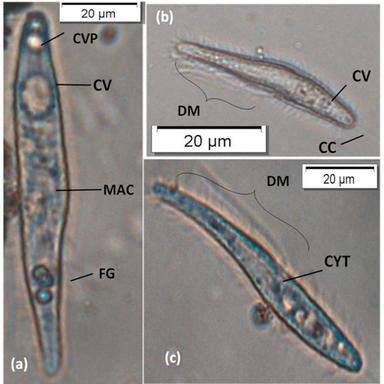
Detailed Image of internal ultrastructure of coral associated ciliate Cohnilembus verminus. (a) Showing CVP-Contractile vacuole pore, CV- Contractile vacuole, MAC – Macronuclei, FG- Food granule (b) Complete external ciliature of C. verminus (c) Showing DM Double membranelles, CYT – Cytostome. Scales included are added from microscopy images.